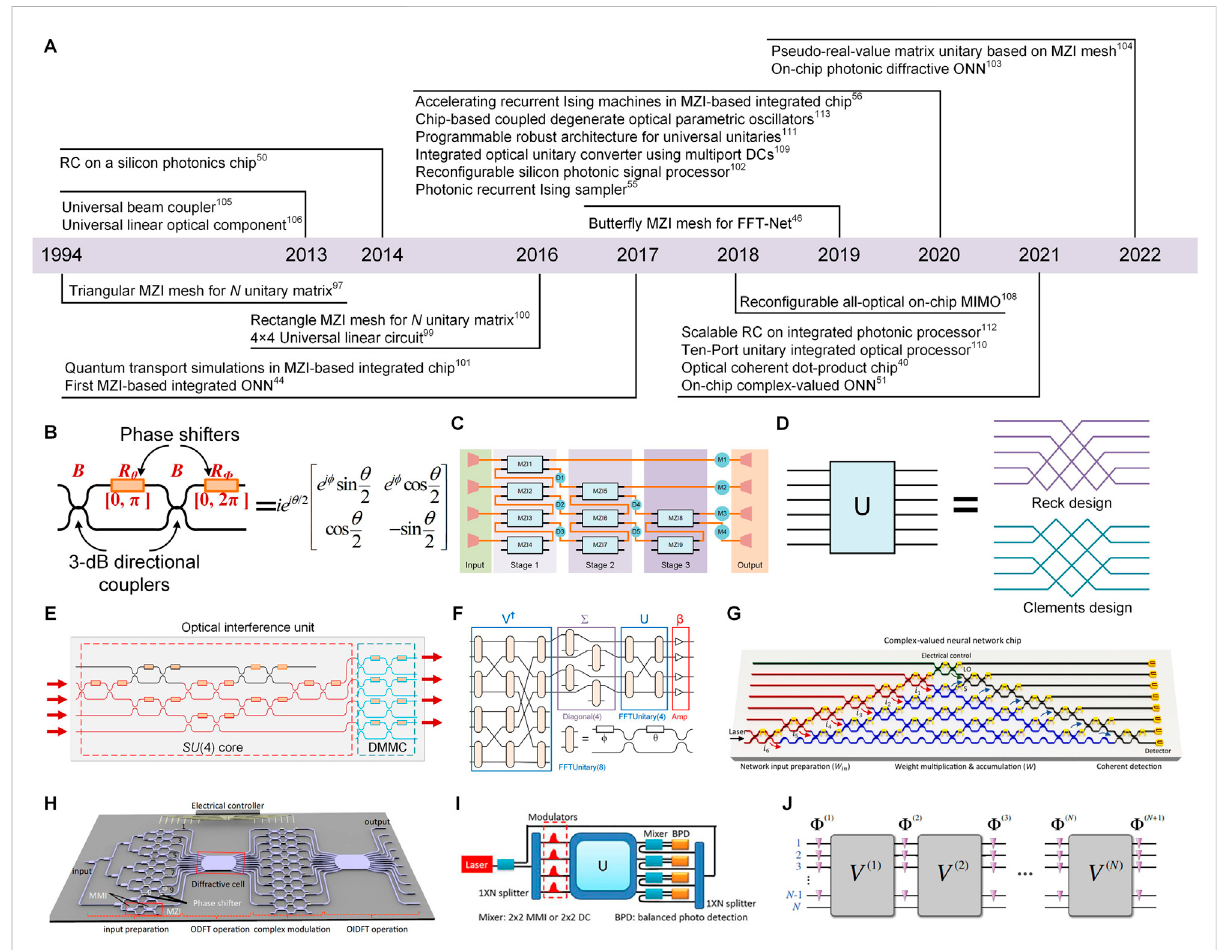
FIGURE 2 (A) The progresses of analog optical computing in the coherent integration platform. (B) Schematic of a Mach – Zehnder interferometer (MZI). (C) Schematicofa4×4-portuniversallinearcircuit[99]. (D) SchematicofReckdesignandClementsdesignfortheunitaryimplementation[100]. (E) Schematic of the optical interference unit (OIU) [44]. (F) Schematic of the “ FFTUnitary ” [46]. (G) Schematic of the complex-valued ONN [51]. (H) Schematic of the integrated chip diffractive neural network [103]. (I) Schematic of the pseudo-real-value matrix unitary MZI mesh [104]. (J) A robust architecture for universal unitary [111]. (G) Reprinted from Ref. [51] with permission from Springer Nature: Nature Communications. (H) Reprinted from Ref. [103] with permission from Springer Nature: Nature Communications. (I) Reprinted from Ref. [104] with permission from